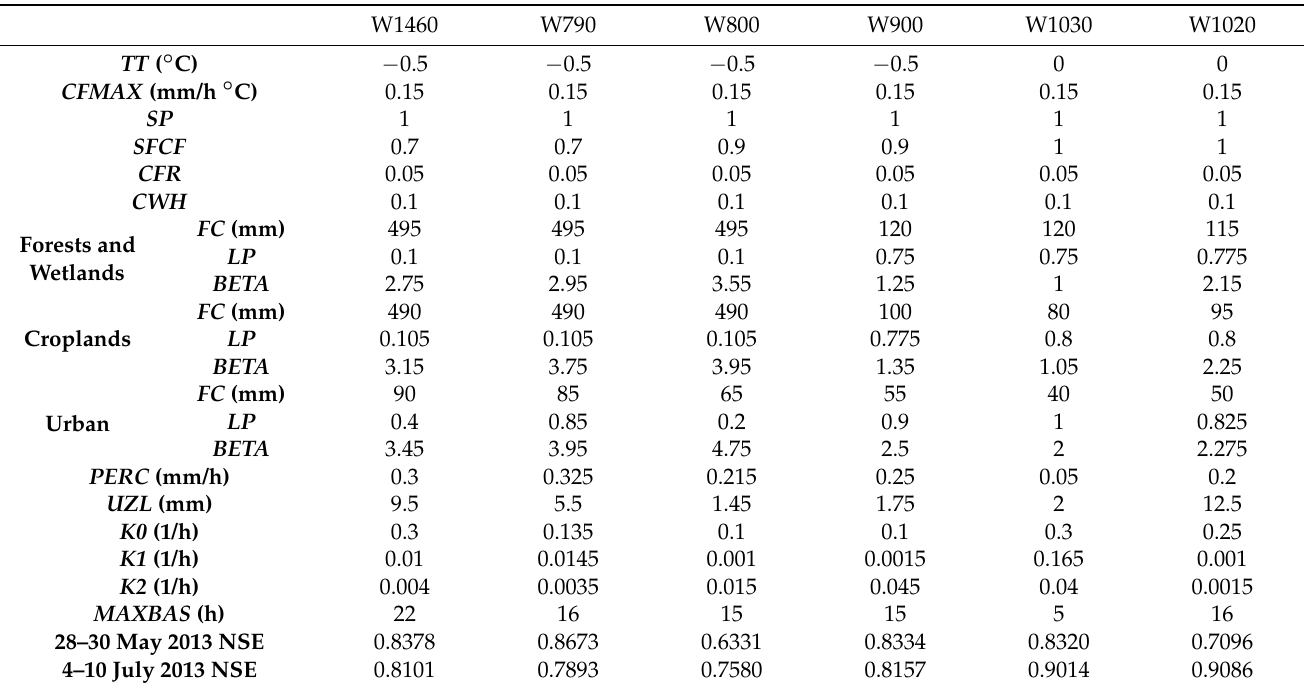
Table 10. Optimal values’ parameters via calibration of the HBV-light (a recent version of Hydrologiska Byråns Vattenbal- ansavdelning) model for the events of 28–30 May 2013 and 4–10 July